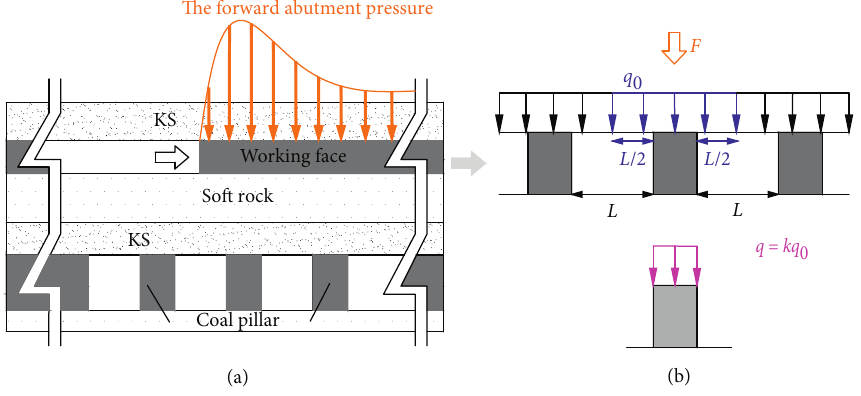
Figure 2: Coal pillar stress analysis in mining above gob